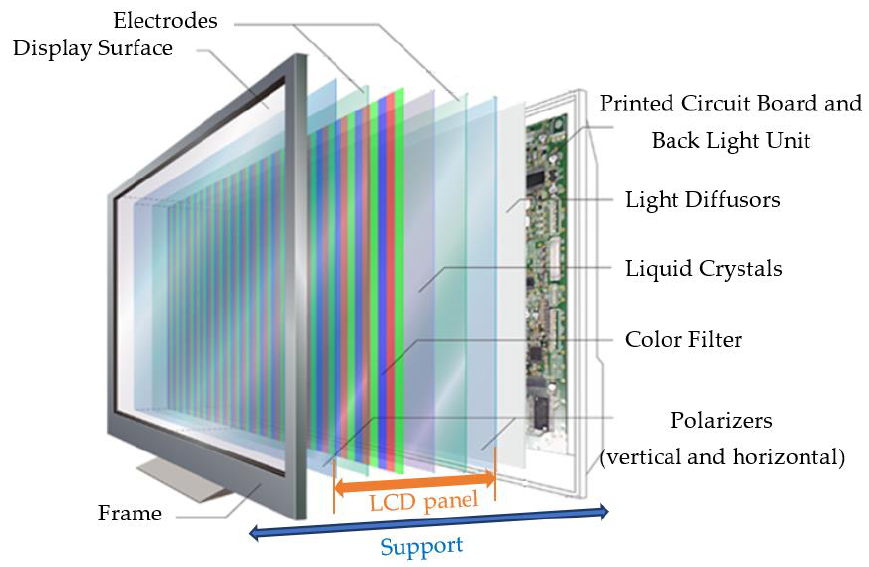
Figure 1. Structure of an LCD-TV module (from [13]).